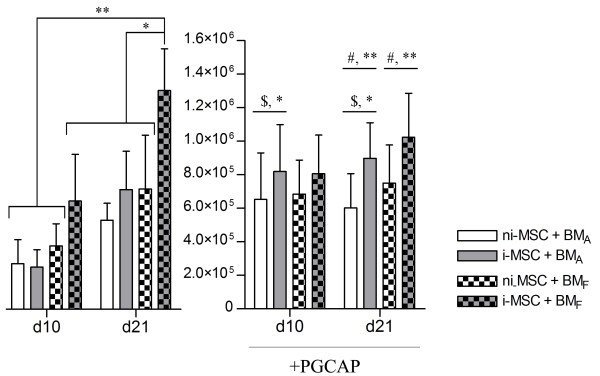
Effect of PGCAP on mesenchymal stromal cell (MSC) and osteoprogenitor proliferation loaded on BMA and BMF. Not induced-MSCs (ni-MSCs) or osteogenic induced-MSCs (i-MSCs) loaded on BMA and BMF biomaterials at high cell seeding density (20 × 103 cells per biomaterial) were embedded or not in PGCAP and grown for 21 days. The number of cells was evaluated in each condition at days 10 and 21. The data are expressed as mean ± standard error of the mean. A statistically significant difference between individual conditions (without PGCAP) was revealed by analysis-of-variance test followed by Student Newman-Keuls. *P <0.05, **P <0.01. With PGCAP, similar tests revealed statistically significant difference between group comparing ni-MSCs and i-MSCs loaded on BMA ($*P <0.05) or group comparing ni-MSCs and i-MSCs at day 21 (#**P <0.01). PGCAP, platelet glue obtained from cryoprecipitation of apheresis platelet products.